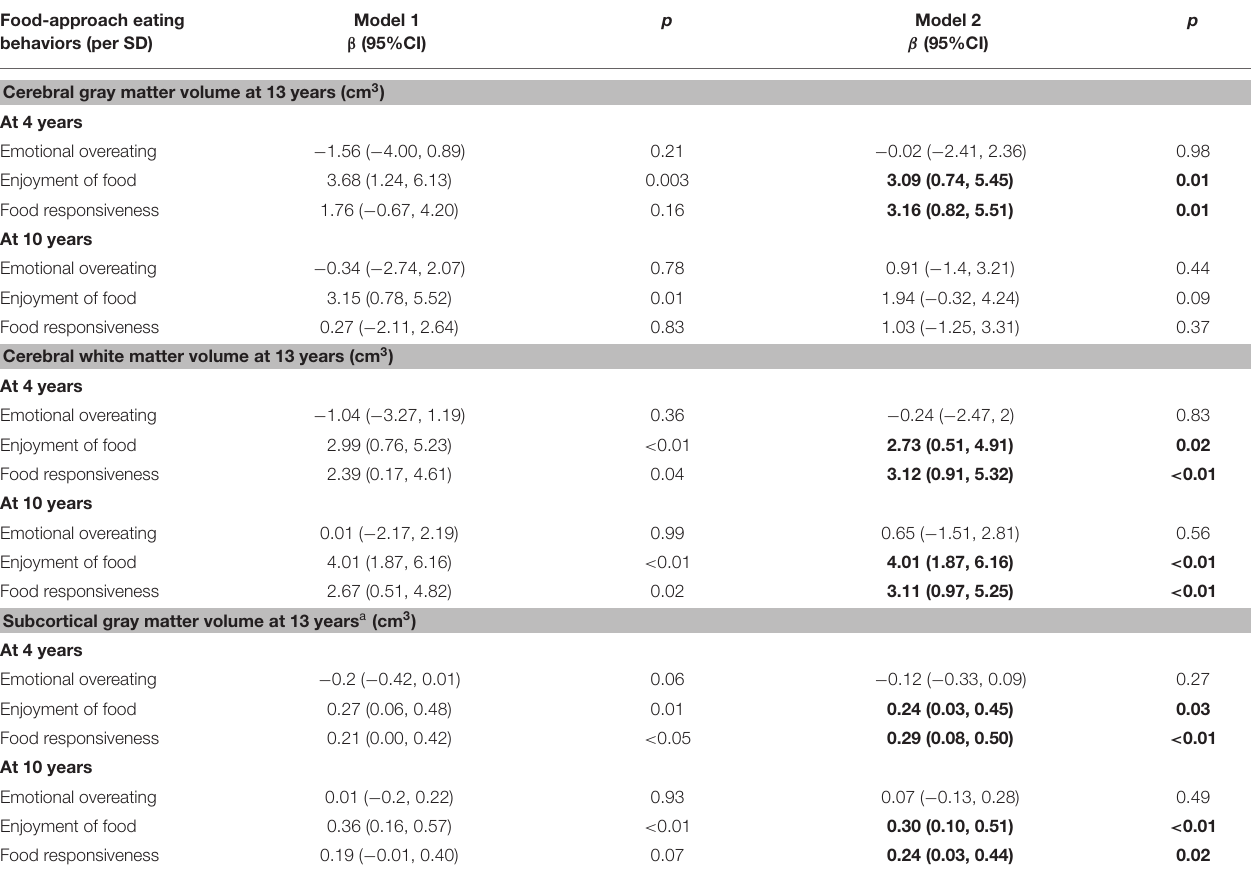
TABLE 2 | Associations between food-approach eating behaviors at ages 4 and 10 years with brain volumes at age 13 years. Food-approach eating behaviors (per